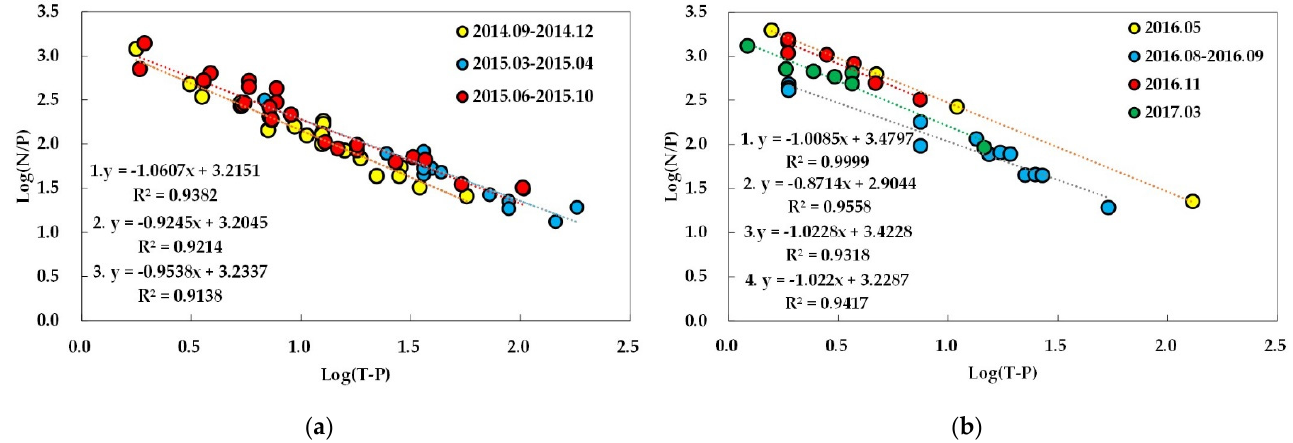
Figure 7. Regression analysis between TN/TP and TP in ( a ) period 1 and ( b ) period 2. The numbers of regression equations in the figures are in chronological order.